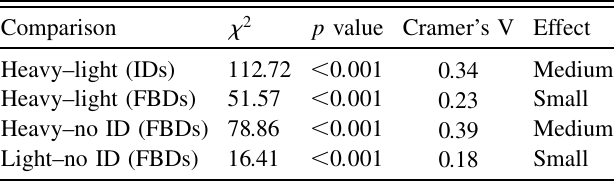
TABLE VIII. Statistical comparisons between the groups in terms of quality of IDs and